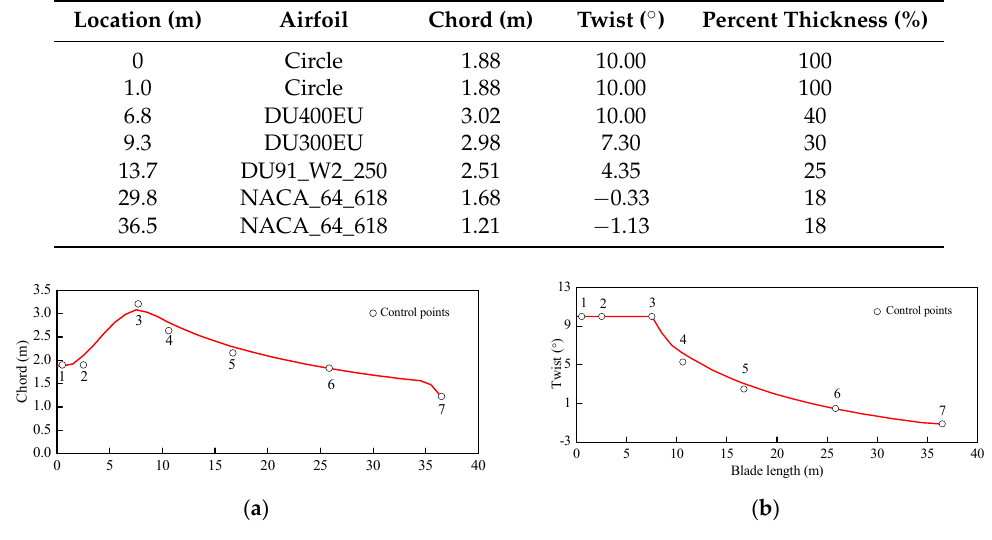
Figure 2. ( a ) Chord and ( b ) twist distribution of the blade.